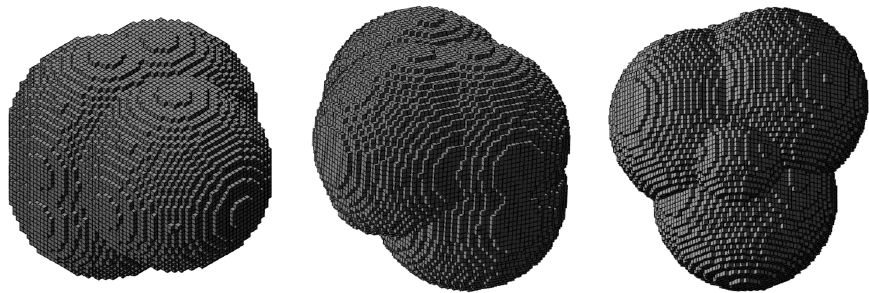
Figure 6. Three views of the exemplary model of a pore with convex boundaries.